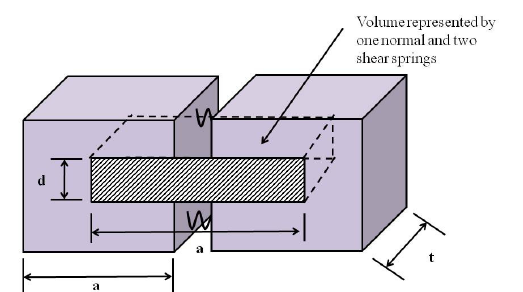
Fig. 1. AEM elements and springs